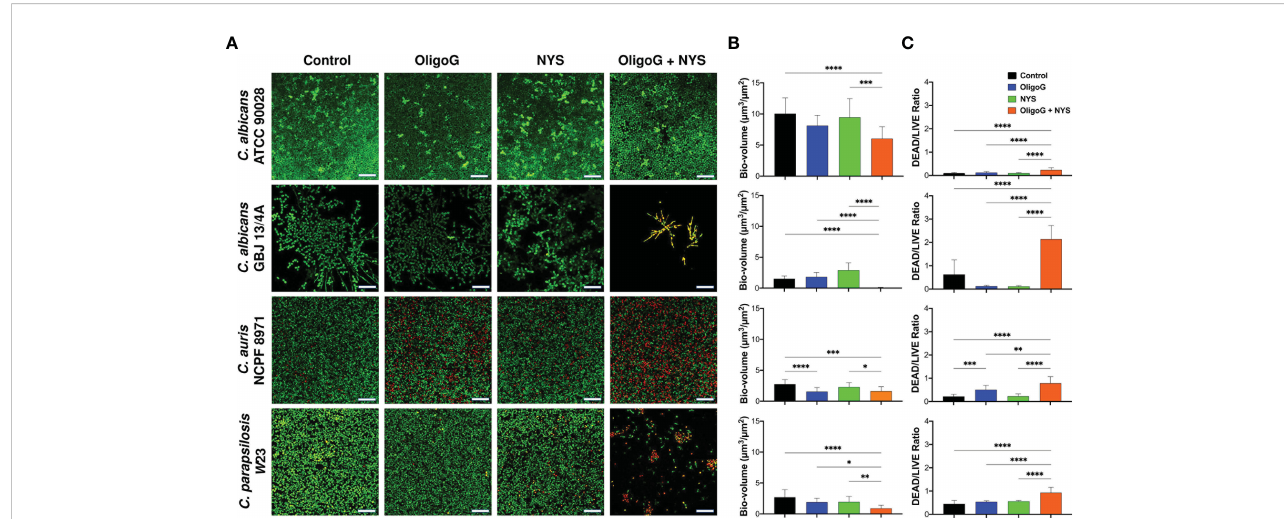
FIGURE 2 CLSM imaging of C. albicans ATCC 90028, C. albicans GBJ 13/4A, C. auris NCPF 8971 and C. parapsilosis W23 bio fi lm formation (24 h) treated with 4% OligoG in combination with 1 m g/ml nystatin (NYS). (A) Z-stack imaging; scale bar = 40 m m. Corresponding COMSTAT analysis of (B) bio fi lm biovolume (µm 3 /µm 2 ) and (C) DEAD/LIVE bacterial ratio (n=3). Group wise comparisons were analysed using one-way ANOVA followed by Tukey ’ s post hoc tests *p < 0.05; **p < 0.01; ***p < 0.001; ****p <